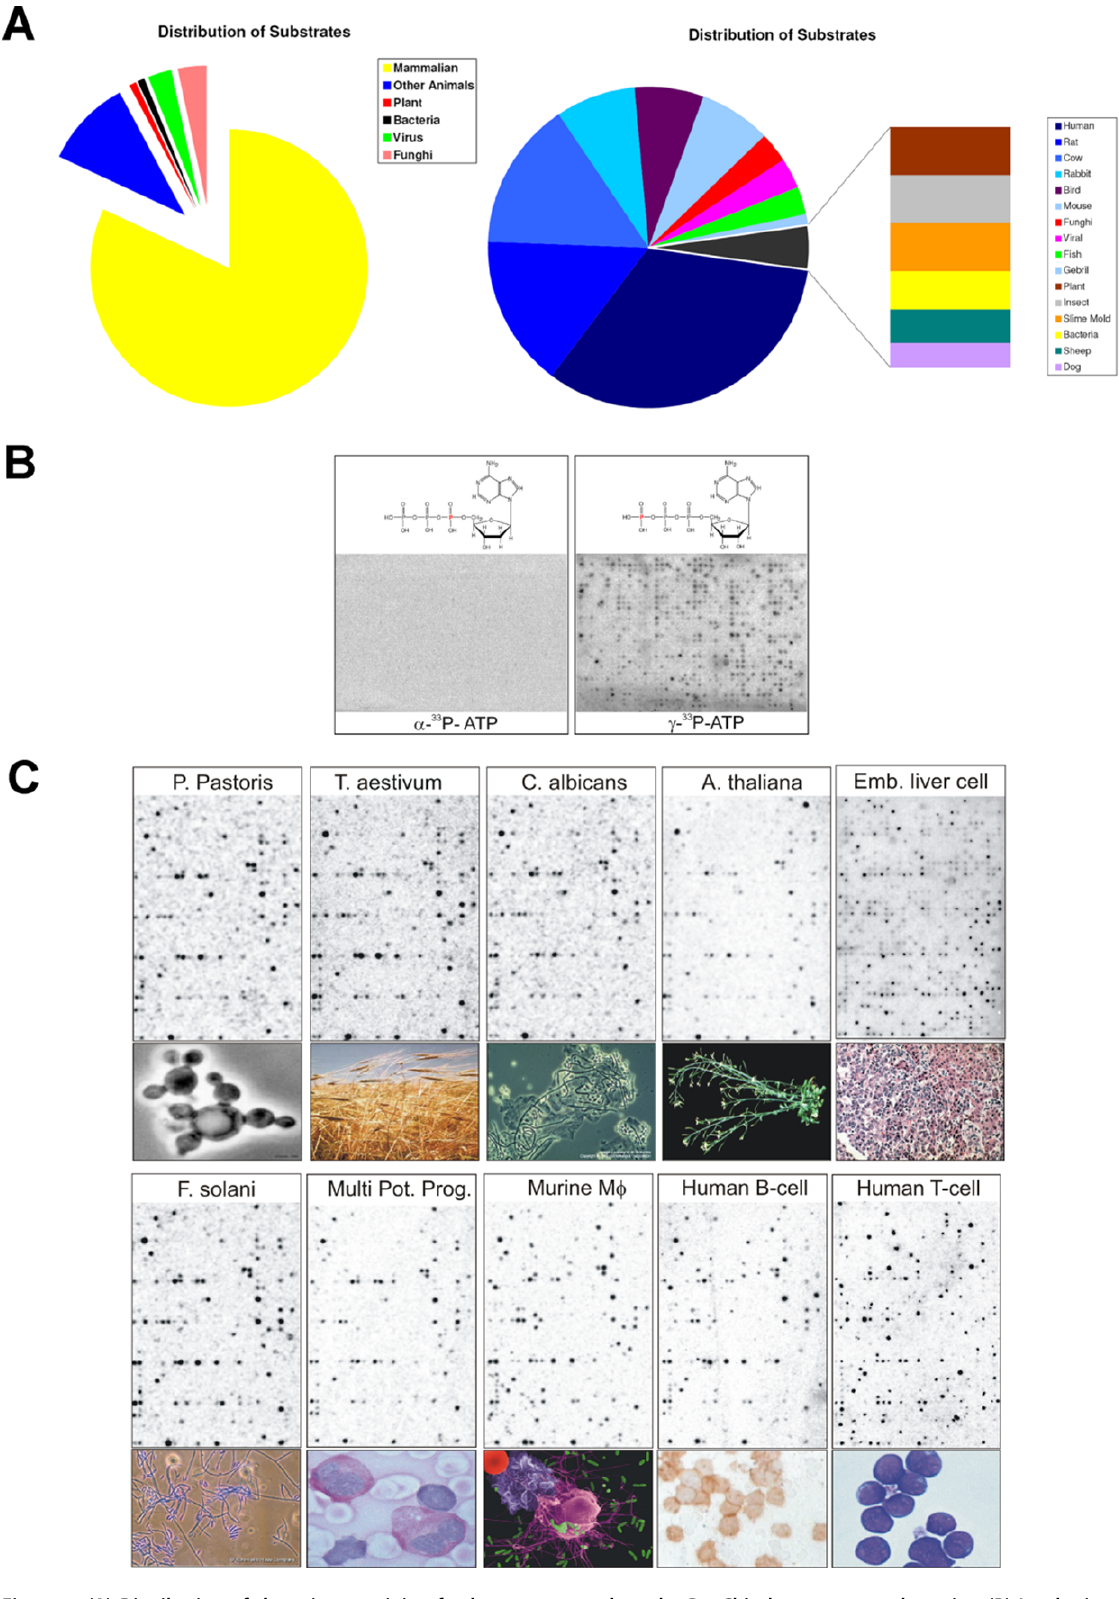
Figure 1. (A) Distribution of the primary origin of substrates spotted on the PepChip by regnum and species. (B) Incubation of a lysate on a PepChip with equal amounts of [ 33 P- a ]- and [ 33 P- c ]-labelled ATP to show functional phosphorylation (C) Weighted average of at least three PepChip profiles of the different samples.